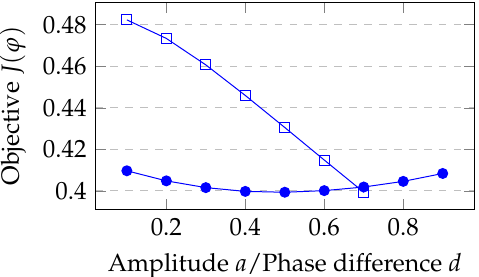
Figure 8. Influence of design parameters. Segregation intensity for ∆ x = 36.9 µ m and varying amplitude/phase difference. Squares: t p = 0.8 s, d = 0.5, a is varied. Circles: t p = 0.8 s, a = 0.7, d is varied.